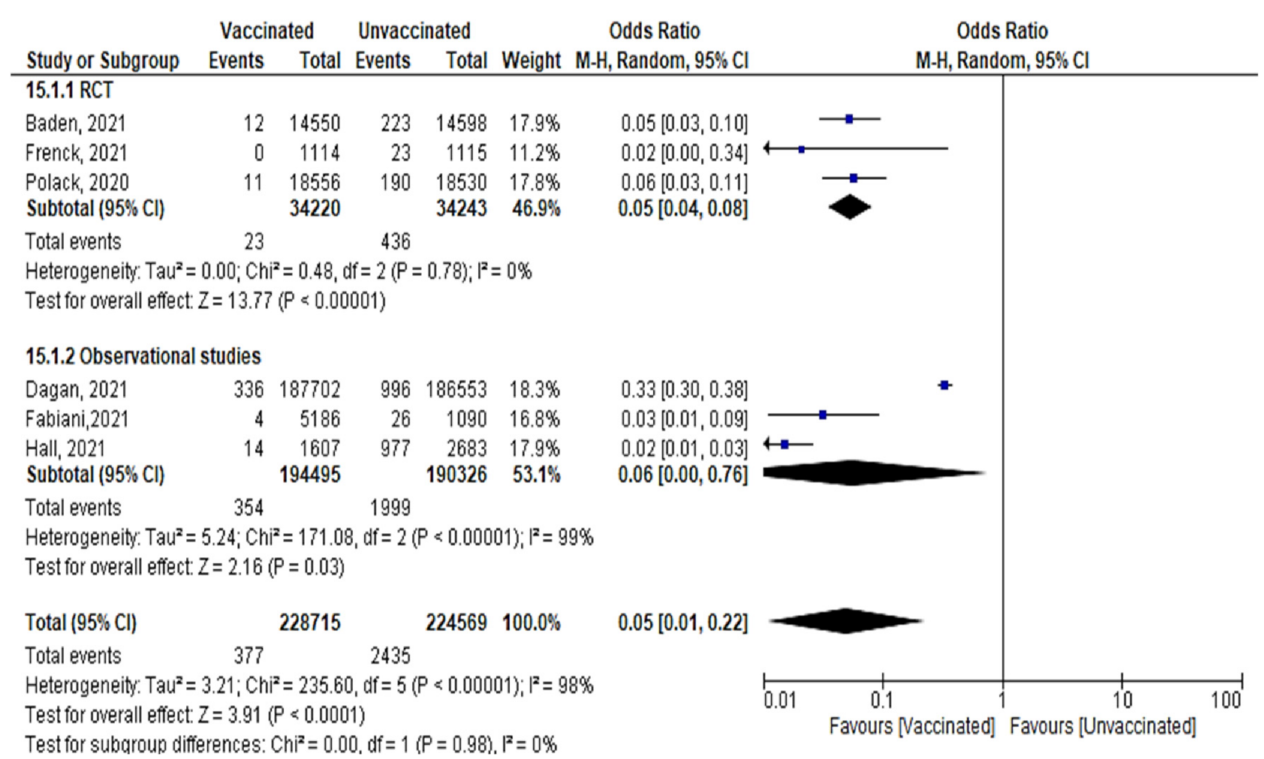
Figure 13. All cases of confirmed SARS-CoV-2 infection reported after 2nd dose of vaccination regardless of the